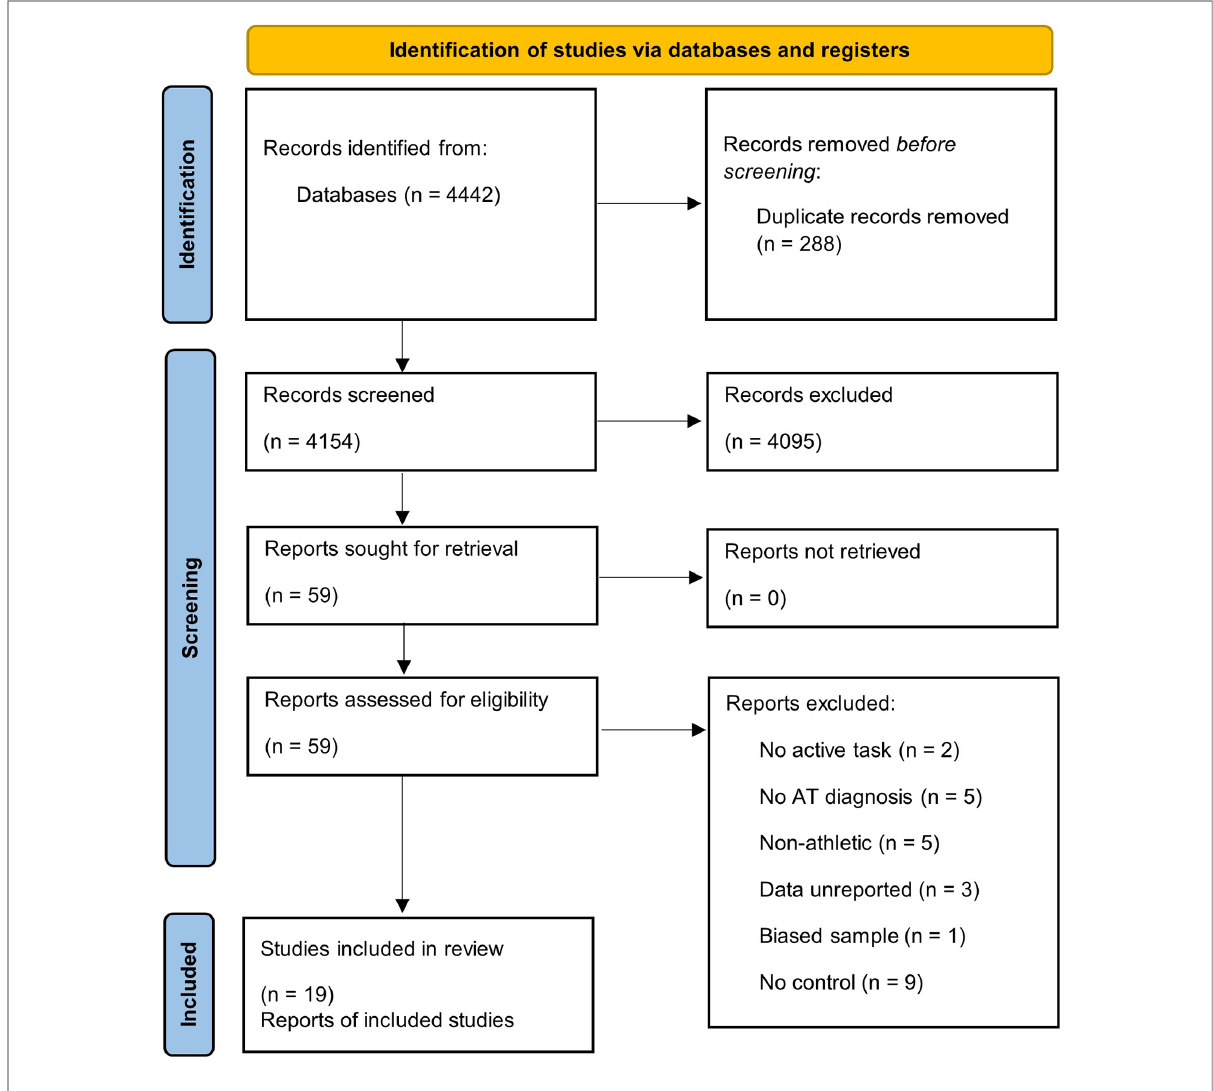
FIGURE 1 PRISMA fl ow